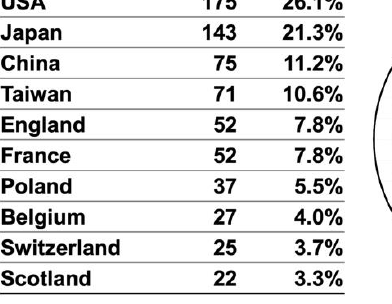
Figure 3. The top 10 countries contributing the most to the area of PCSEL and the corresponding world choropleth map for the relevant publications retrieved from Clarivate Analytics’ Web of Science (WoS) bibliometric database. Inset: A zoom-in view of Taiwan (blue dashed line square), whose population base is far less than the other highly ranked, has the competitive potential in the PCSEL research area.